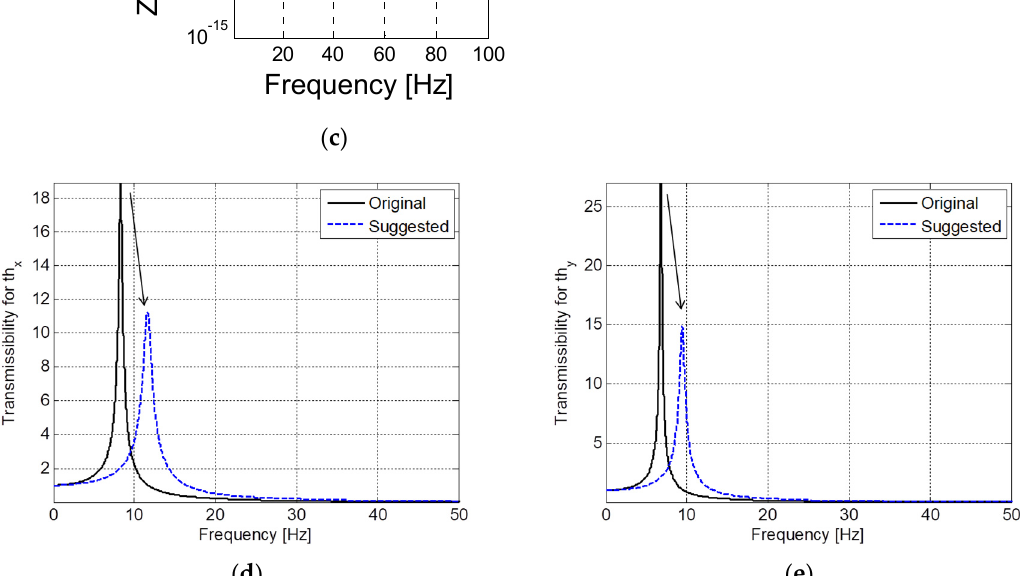
Figure 15. Performance estimation with the suggested mount configuration: estimated vibration at the center of gravity (CG) ( a ) in rotational x-axis( θ x ); ( b ) in rotational y-axis( θ y ); ( c ) in translational z-axis(z) and transmissibility in the rotational direction; ( d ) θ x ; ( e ) θ y